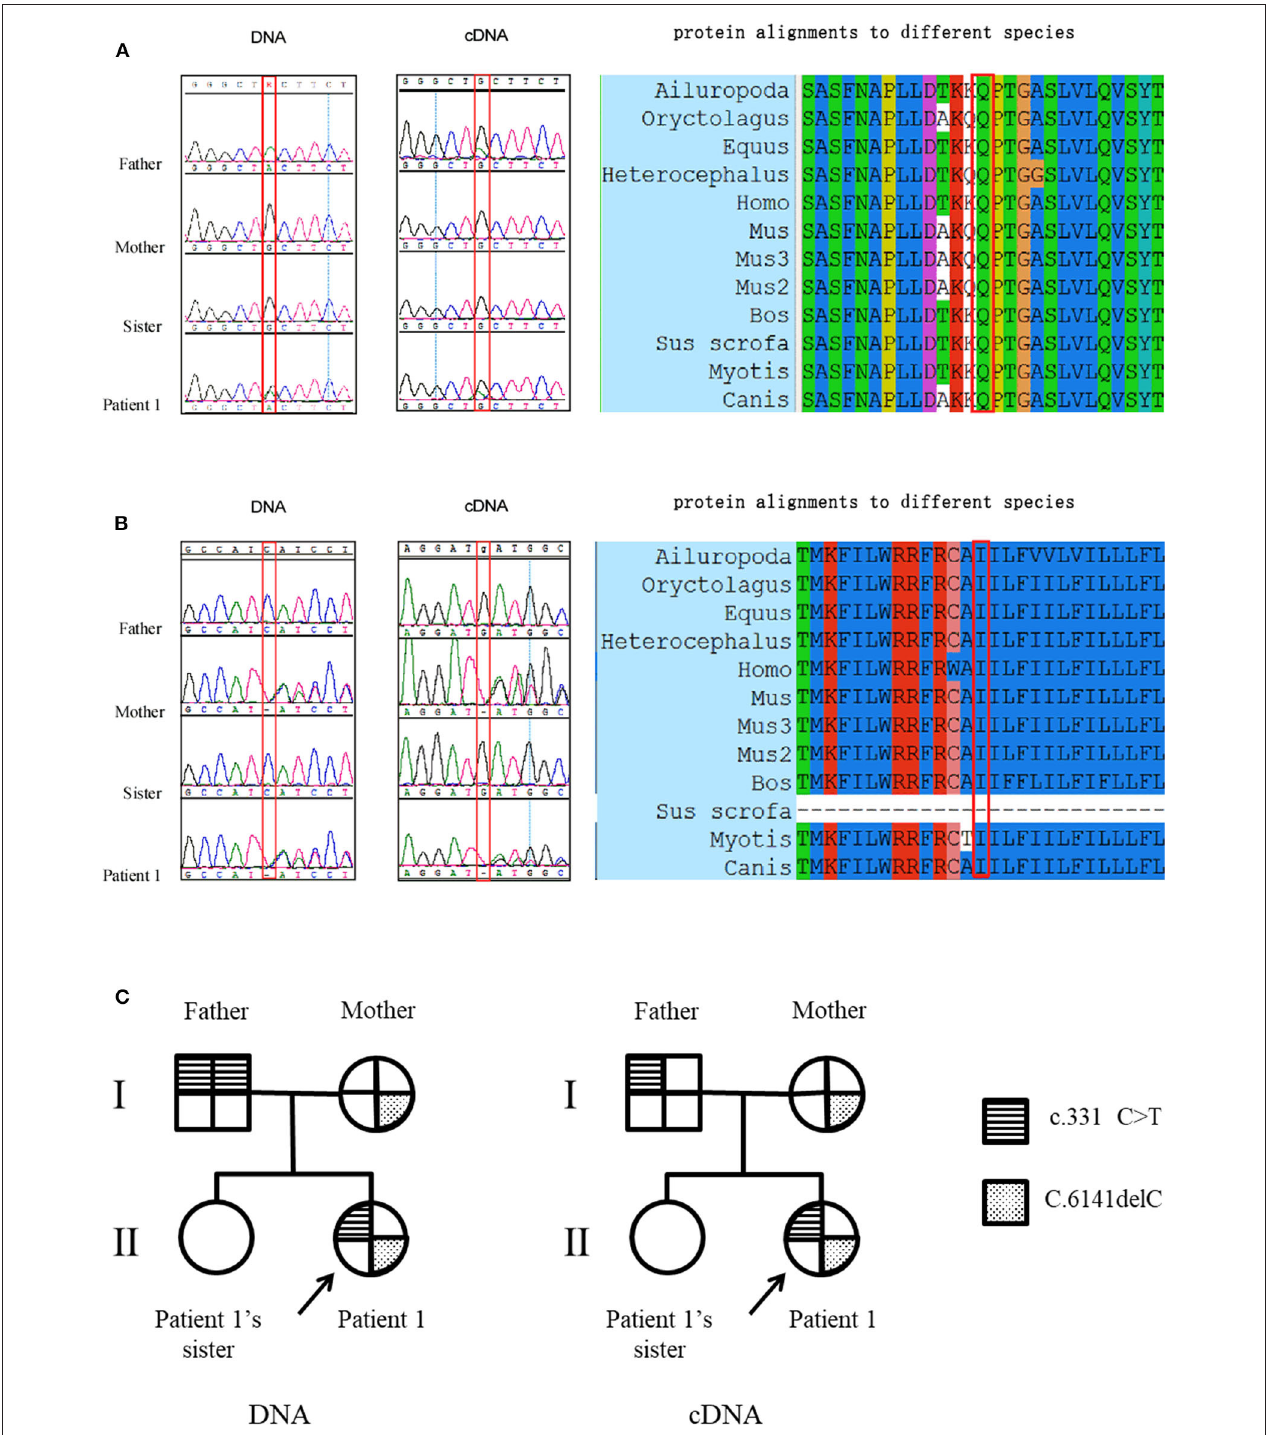
FIGURE 1 | Mutation studies of patient 1’s family. (A) c.331C > T (p.Gln111Ter) mutation analysis in genomic DNA and total PBMC cDNA, together with protein alignments to different species. Note that the father was found to be homozygous for the c.331C > T mutation in genomic DNA while he was found to be heterozygous for the c.331C > T mutation from the total PBMC cDNA. (B) c.6141delC (p.Cys601Stop) mutation analysis in genomic DNA and total PBMC cDNA, together with protein alignments to different species. The protein alignments indicate that these two mutations occur in highly conserved amino acids. (C) The pedigree of patient 1’s family with representation of the segregation of